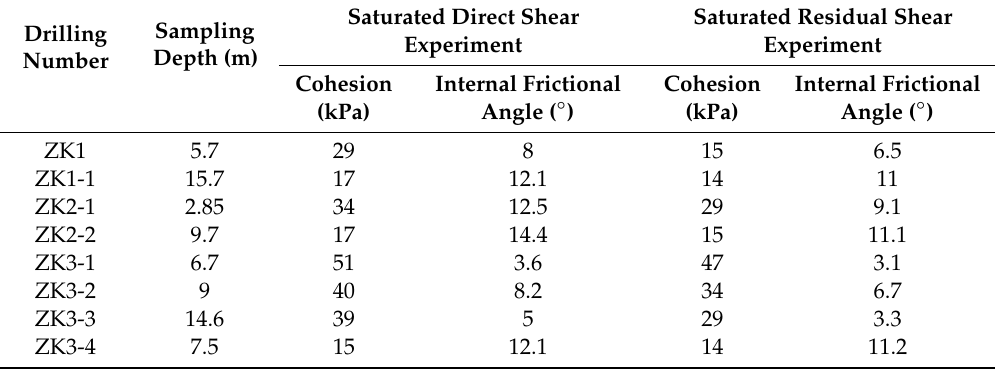
Table 2. Shear strength of slip zone